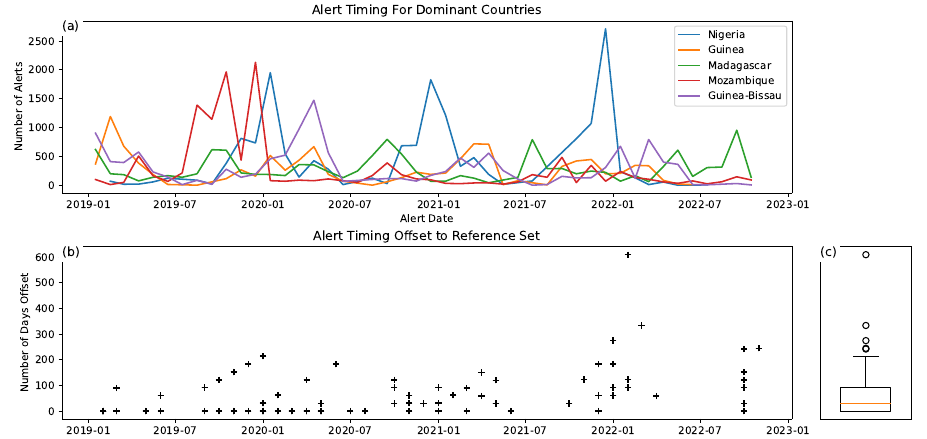
Figure 9. Analysis testing the timing of the alerts versus a reference dataset. ( a ) The number of alerts for the dominant change countries in Africa throughout the period of observation, ( b ) the observed date of change versus the number of days from the reference, and ( c ) a box plot for the number of days difference between the observed and reference date of the change (median = 92 days).